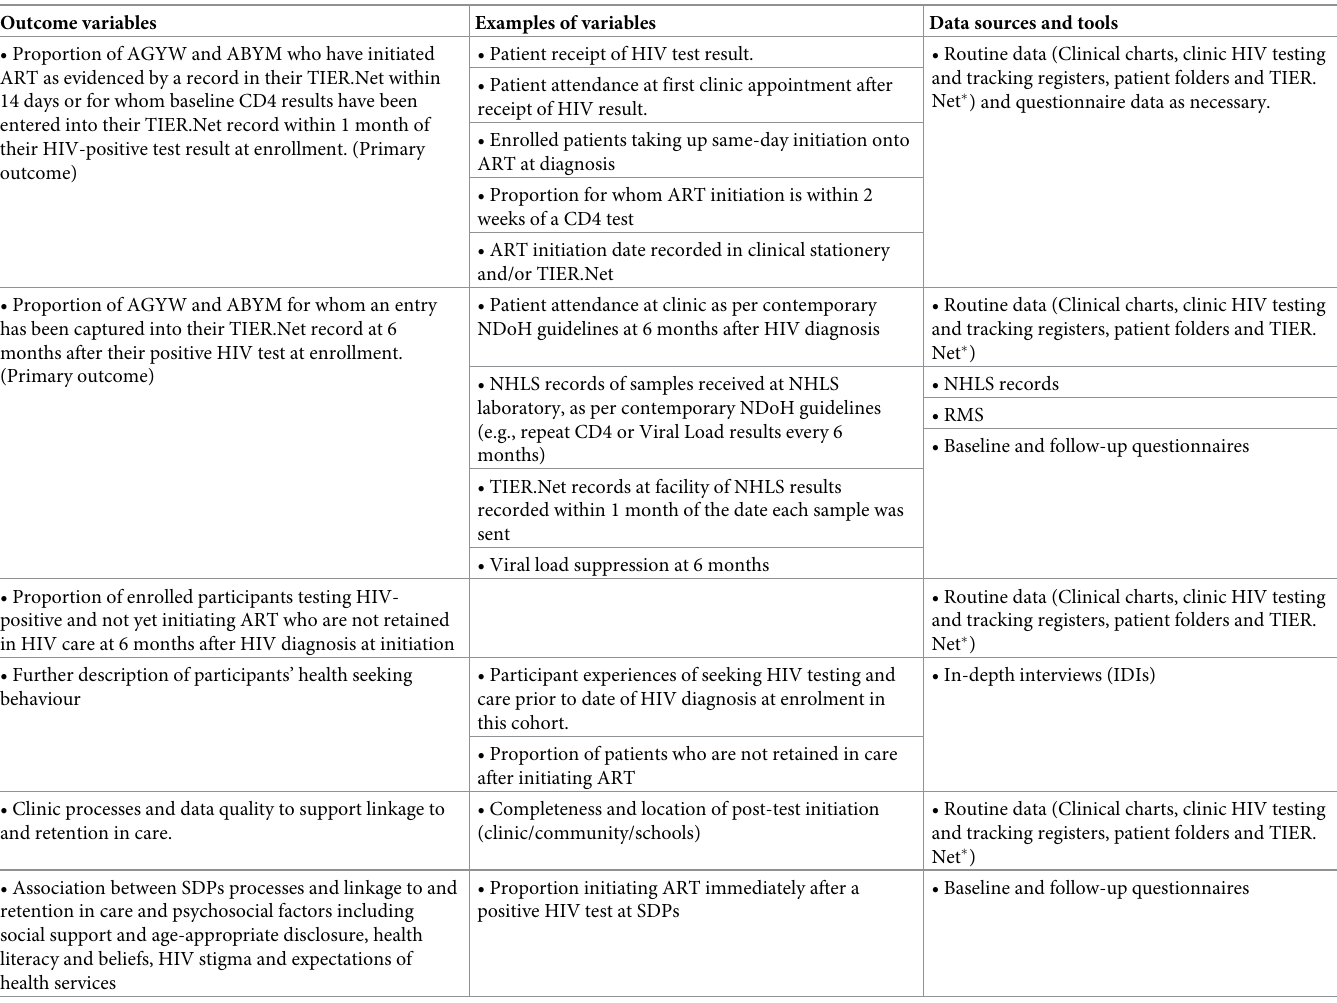
Table 4. Roles of outcome variables in the SHeS’Cap-Linkage study in uMgungundlovu district, KwaZulu-Natal, 2021–2023. Outcome